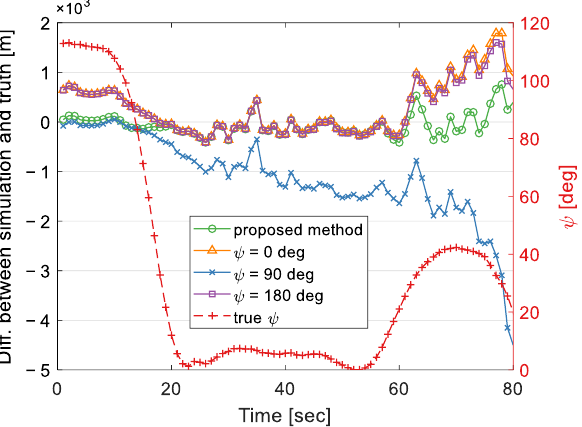
Figure 9. The difference between the measured results and corresponding simulation with the same slope under the different slope aspects.